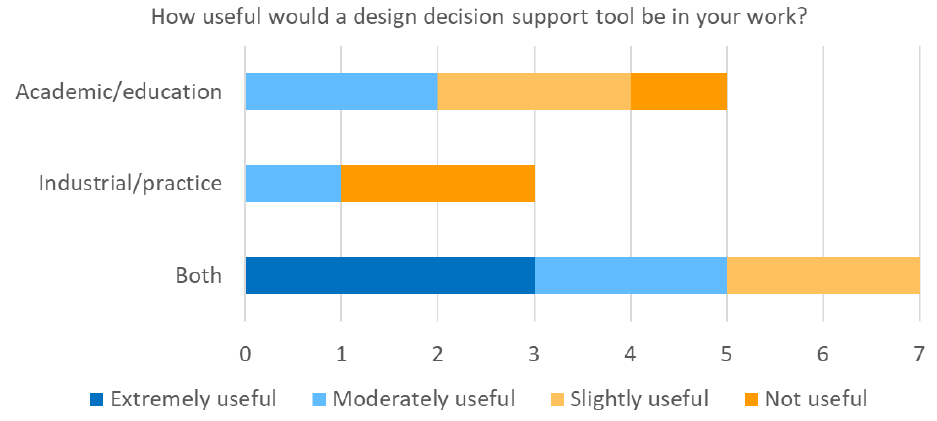
Figure 4. Perceived usefulness of PD